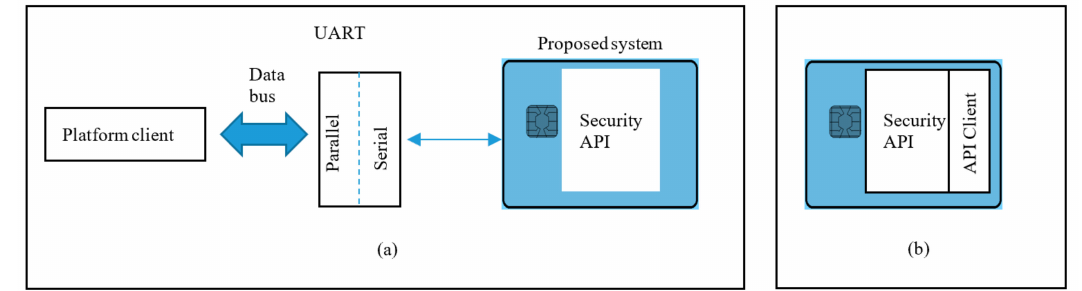
Figure 2. The proposed system consists of a smart card operating system platform integrated with an API to provide security functions whose inputs and outputs are accessible by the transmit and receive lines respectively of a serial port. ( a ) denotes physical interface between an IoT device and the proposed system and ( b ) Configuration 1: alternative solution with a software (instead of a serial port) interface.